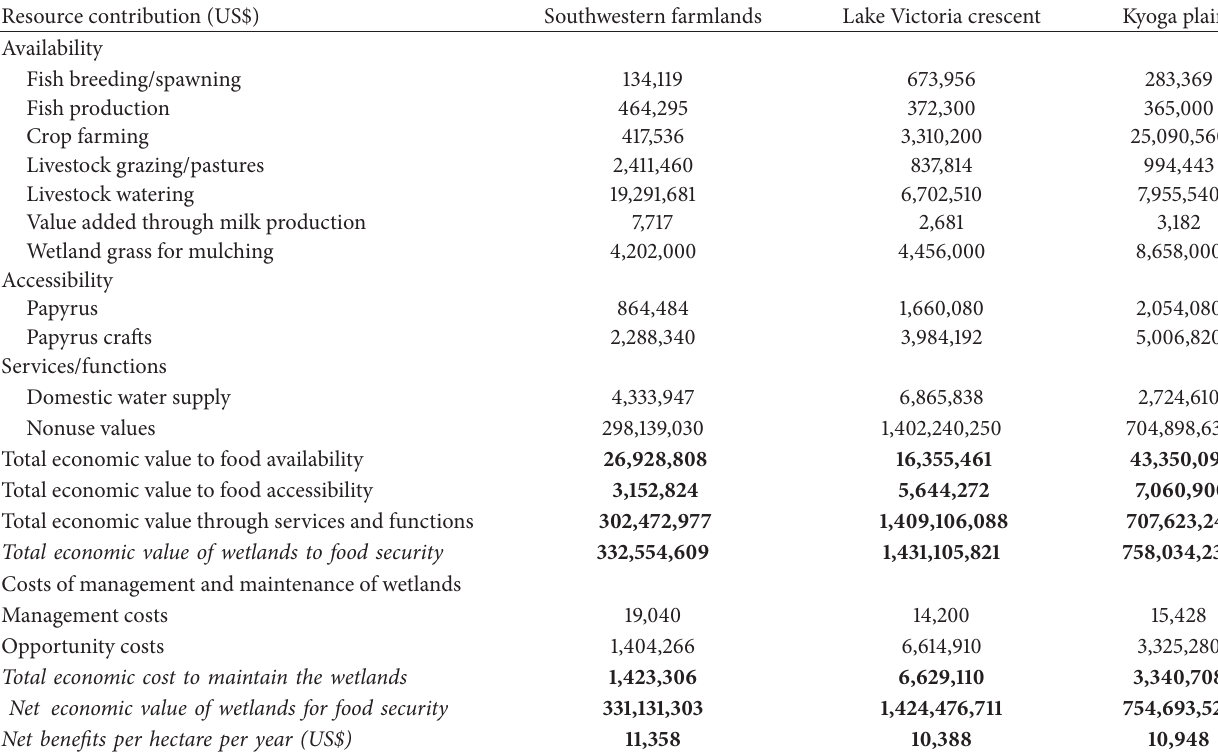
Table 15: Summary of total economic contribution of wetlands in three agro-ecological zones of